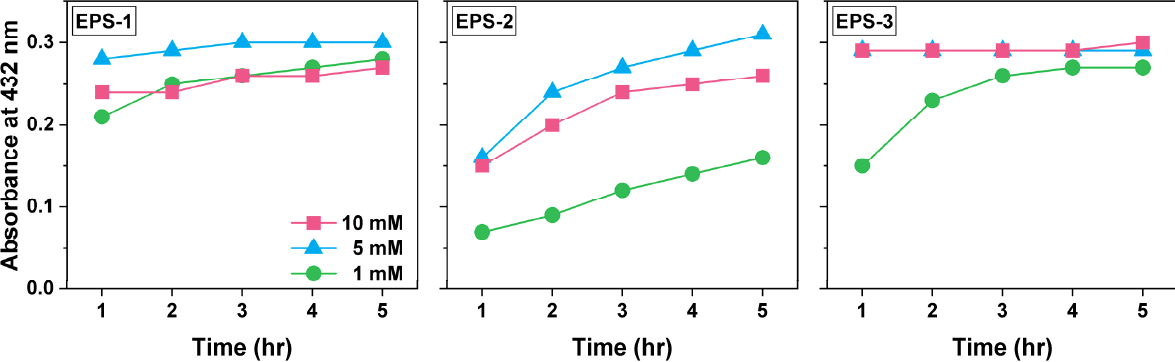
Figure 3. UV–Visible light absorbance at 432 nm of AgNO 3 and EPS solution mixture as a function of reaction time with the AgNO 3 concentration of 1, 5, and 10 mM. Each reaction mixture contained 0.5 g L − 1 EPS, and the reactions were conducted at 100 °C.